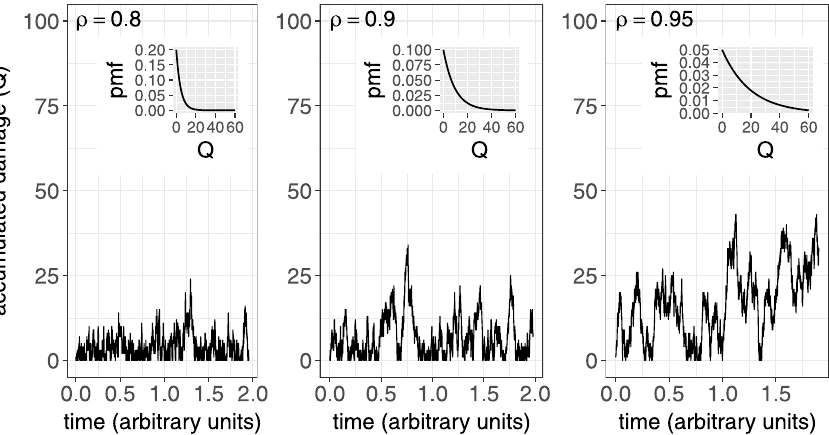
Fig 1. Sample traces of Q ( t ) for three different values of ρ ( λ = 1000). Insets show the corresponding probability mass functions.